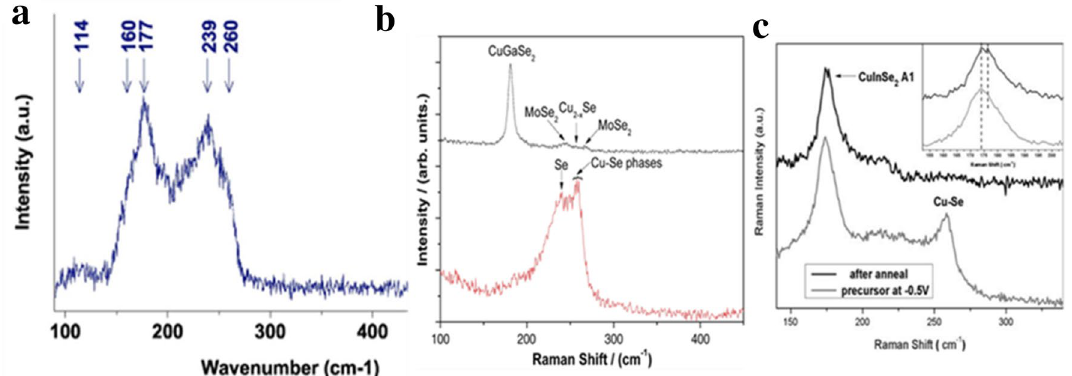
Fig. 11 a Raman spectra of electrodeposited CuInSe mission from Elsevier), c Raman spectra of CuInGaSe 2 (as-deposited 2 thin film (2 µm) (reprinted with permission, Roussel [107], Copyright 2007, The Elec- and annealed) (reprinted with permission, Lai et al. [109], Copyright trochemical Society), b Raman spectra of CuGaSe 2 (as-deposited and 2011, The Electrochemical annealed) (reprinted from Liu et al. [81], Copyright (2012), with per-